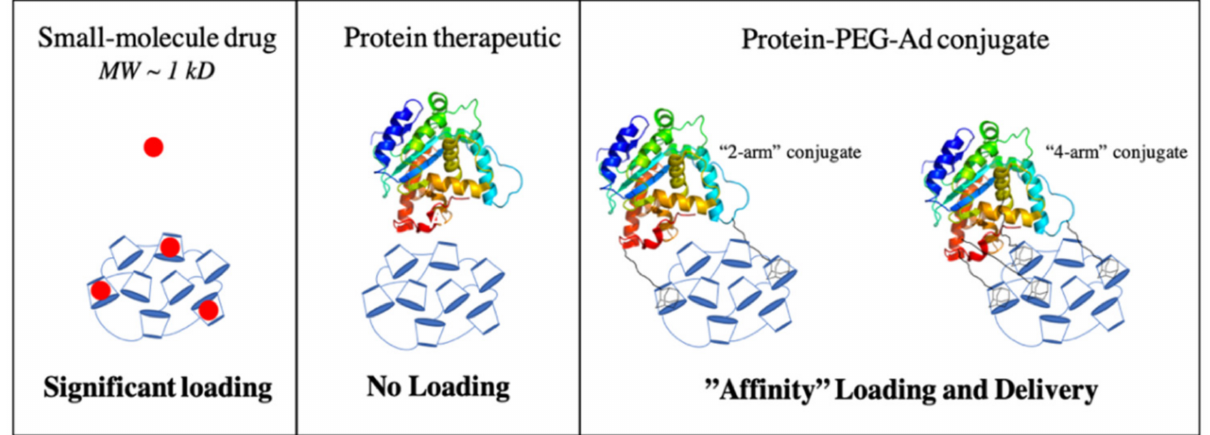
Figure 1. Illustration comparing the loading of small-molecule drugs, protein therapeutics, and protein–PEG–Ad conjugates. Increased conjugation of “PEG-Ad” groups should decrease K D , in- crease thermodynamic interactions between payload and pCD matrix, and ultimately increase loading and prolong